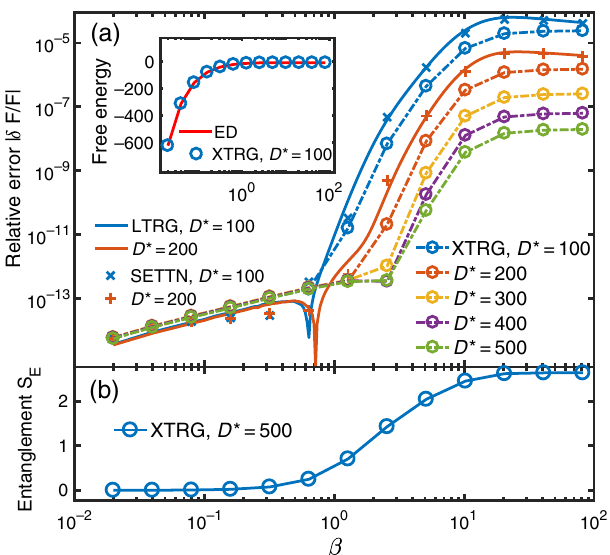
FIG. 5. (a) Relative errors of free energy in an L ¼ 50 spin- 1 = 2 XY chain with OBCs, calculated by TTN algorithms including LTRG, XTRG, and SETTN, with U(1) symmetry encoded, relative to the analytical solution. Similar representation as in Fig. 4, otherwise. Here, ρ ð τ 0 ¼ 0 . 01 Þ is again also initialized using SETTN. (b) Entanglement entropy in the middle of the system. Overall, time costs of LTRG are 7 (7.4) times that of the SETTN run and 363 (183) times that of XTRG, for bond dimension D ¼ 100